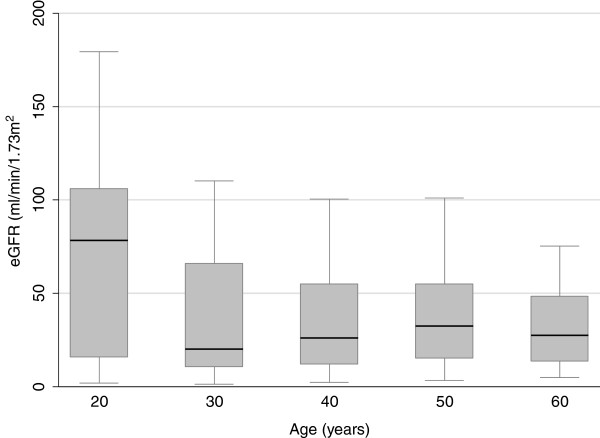
Distribution of patients grouped according to presenting eGFR level and age. The box-and-whisker plot shows the 25th, 50th and 75th percentiles in various age groups.